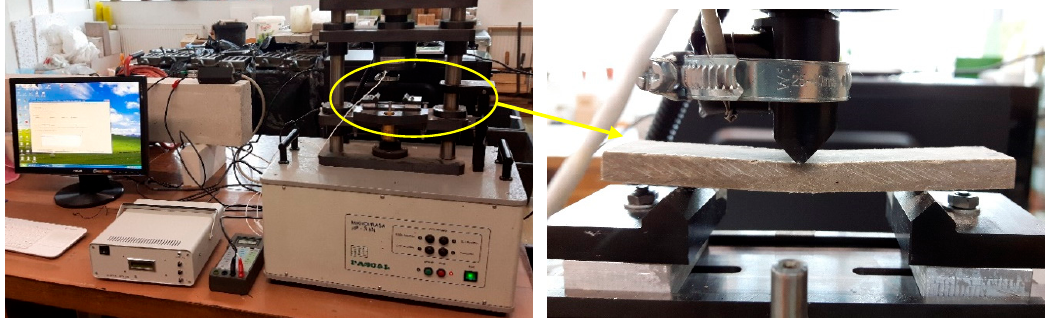
Figure 3. ( left ) Three-point bending test stand and acoustic emission (AE) measuring equipment and ( right ) close-up of fibre-cement board specimen during test.